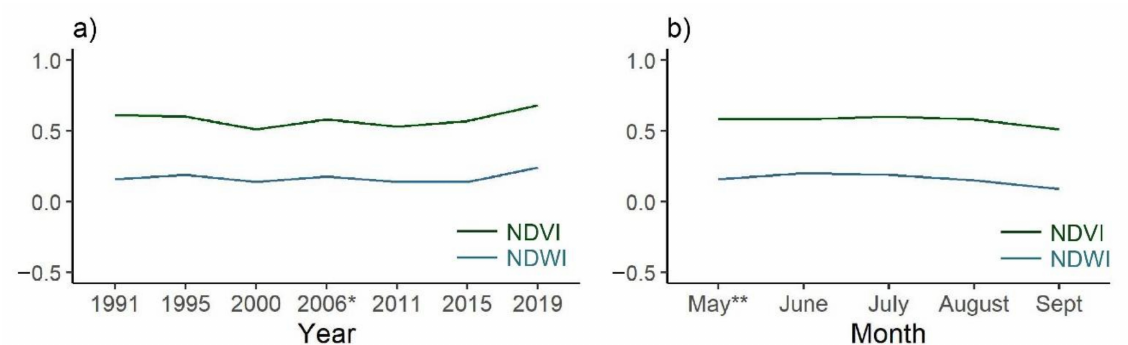
Figure 4. Temporal changes ( a ) and seasonal variation ( b ) in the NDVI and NDWI for Belgrade. * Data for 2006 is based only on one image per growing season that met the criteria of clear atmospheric conditions. ** Data for May is based only on one image during the study period that met the criteria of clear atmospheric